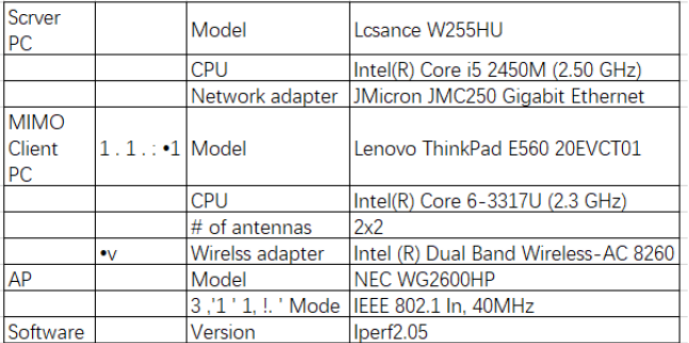
Figure 29. Excel output for scanned table image 6 by Microsoft Office.